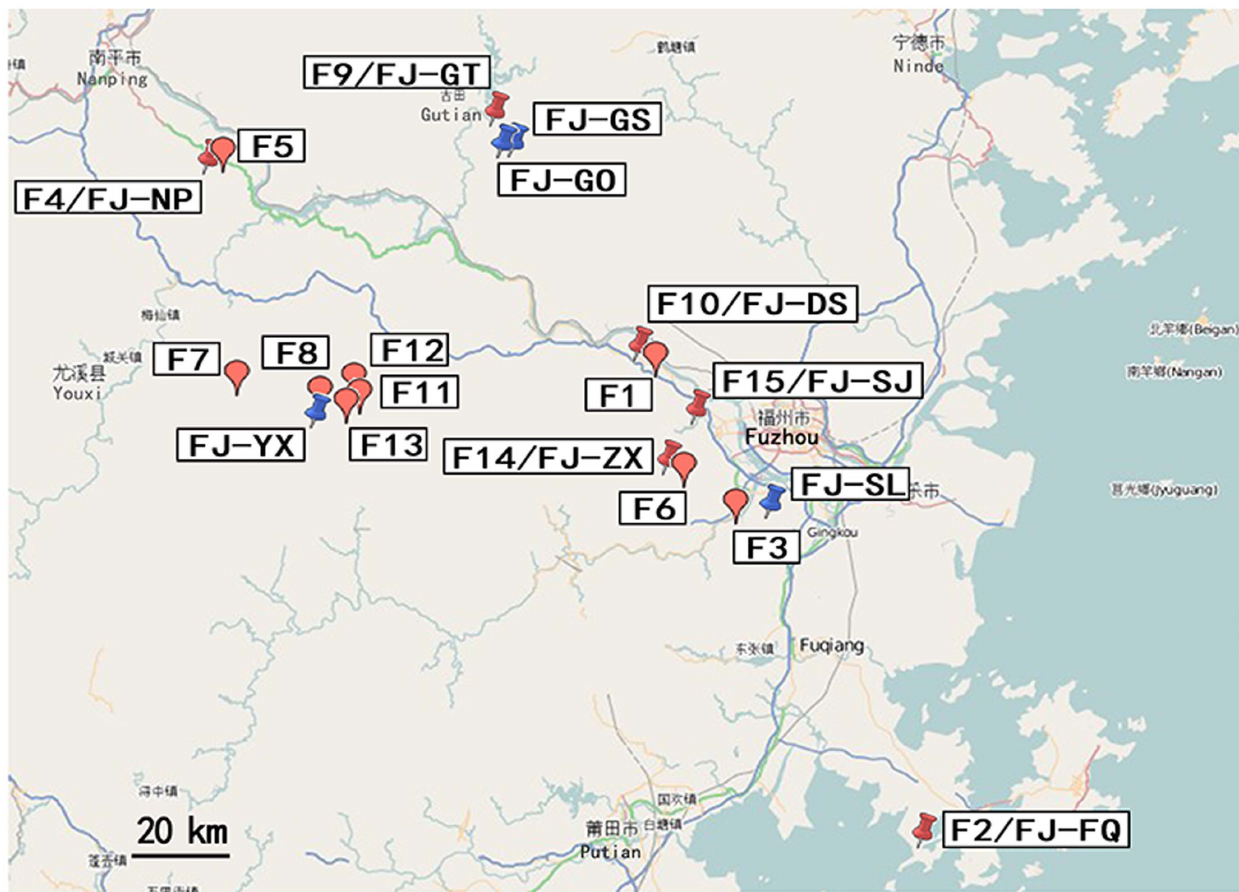
Figure 1. Sites at which samples were collected for investigations of contagious ecthyma and analysis of heterogeneity among orf virus isolates from goats in Northern Fujian Province, China. Red balloon: Sera collection for orf antibodies detection including Farms F1-15. Red thumbtack: Sera collection for orf antibody detection and scab collection for virus isolation and PCR amplification. Blue thumbtack: only scab collection for virus isolation and PCR amplification (http://www.openstreetmap.org/).